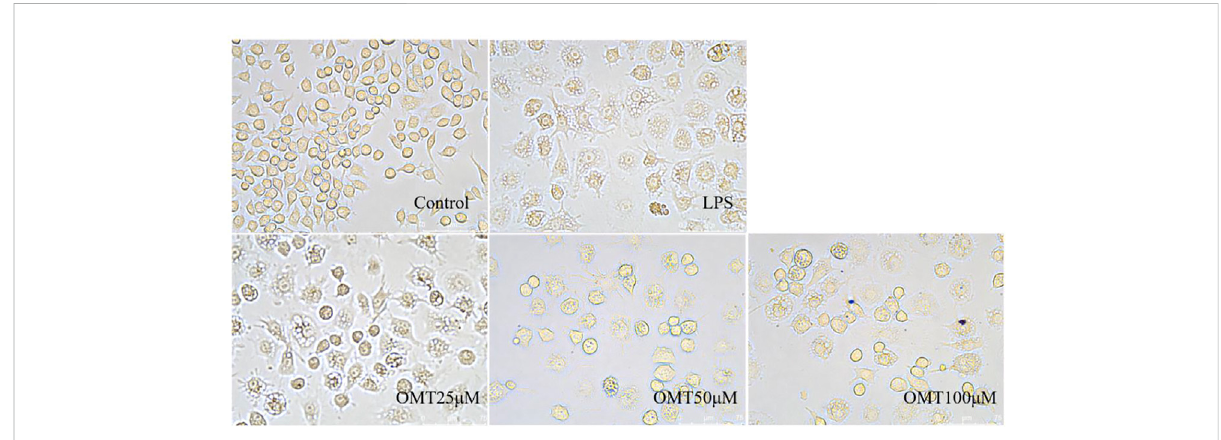
FIGURE 9 The effect of OMT on the cell momhology of LPS-induced RAW264.7 cell in fl ammation model. Each group was visualized by an ordinary light microscope (× 400 magni fi cation).